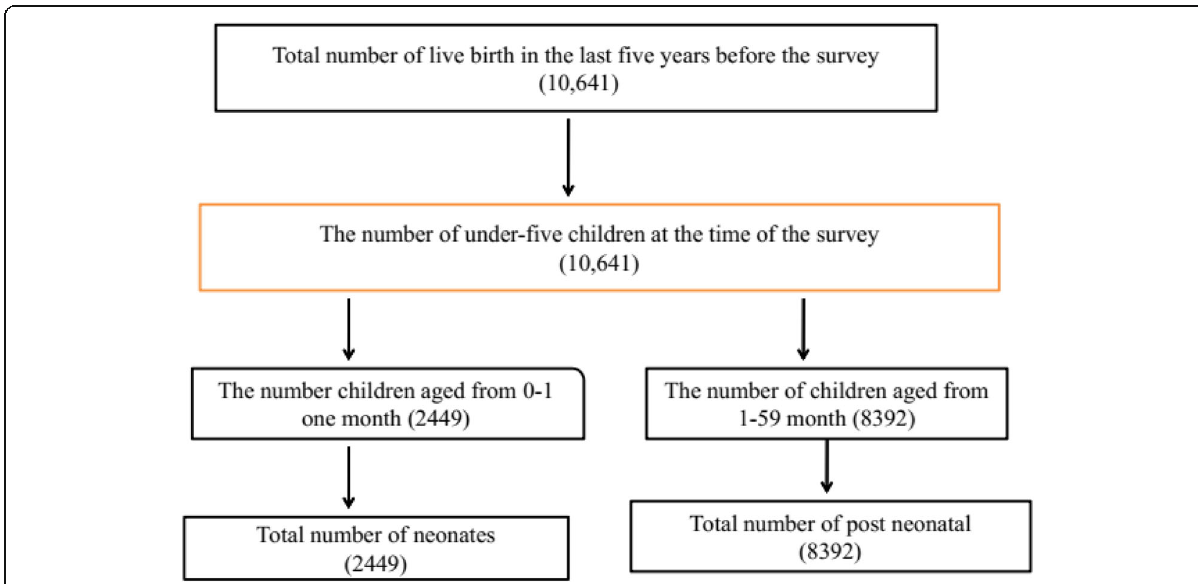
Fig. 1 Total number of neonates included in the analysis in 2016